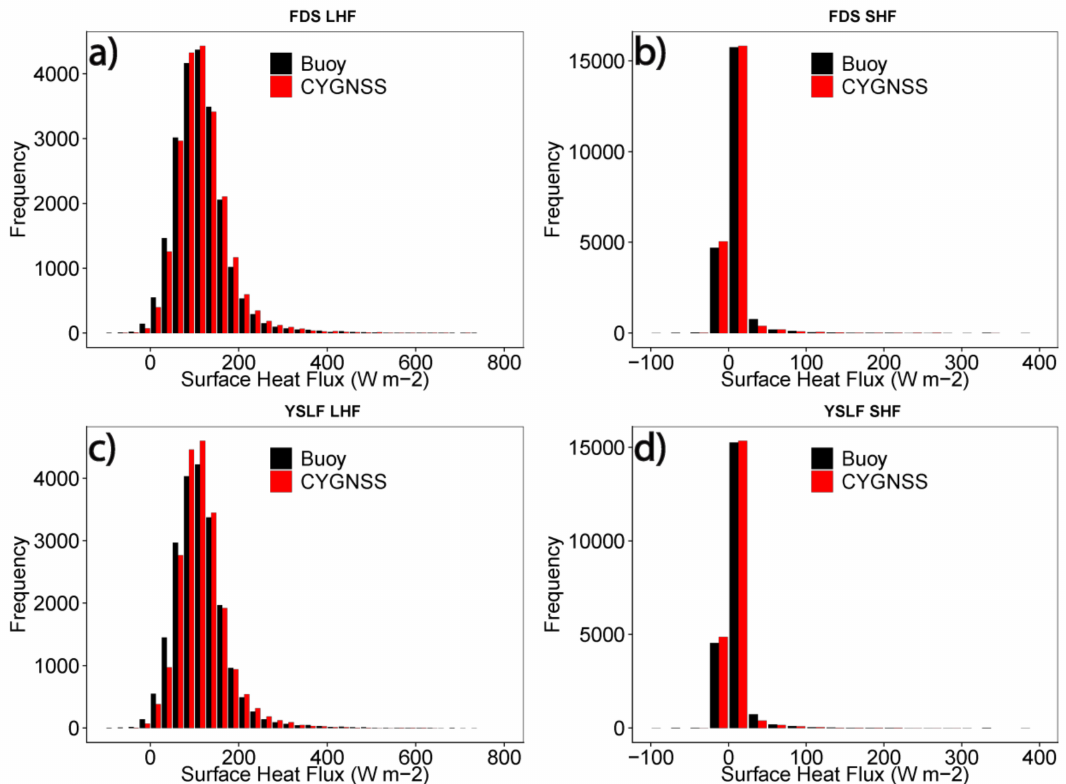
Figure 7. Histogram of surface latent ( a , c ) and sensible ( b , d ) surface heat flux comparisons, binned at 25 W / m 2 , between CYGNSS and buoy data as seen in Figure 5, with buoy on the left and CYGNSS right in each